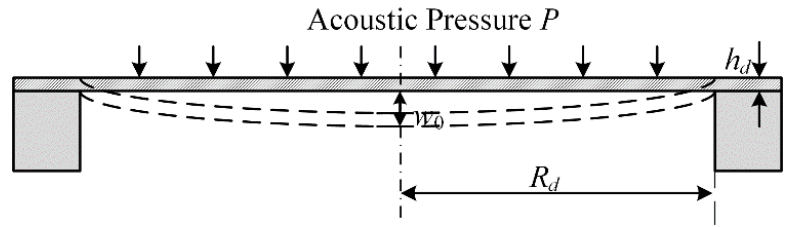
Figure 4. The deflection of a flat circular diaphragm with clamped edges.